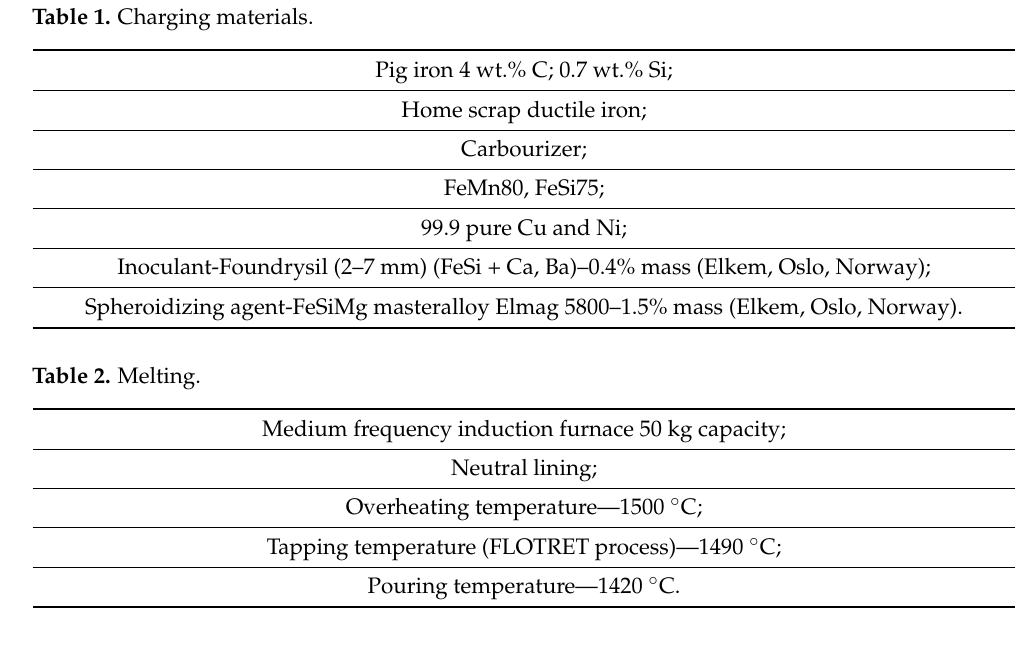
Table 1. Charging materials.